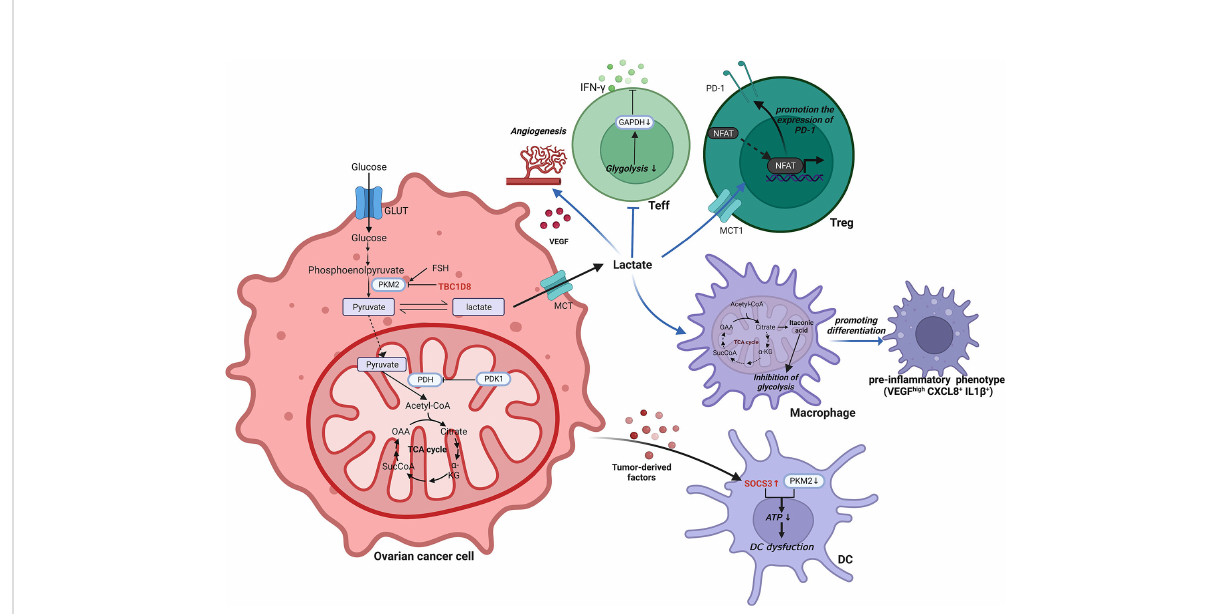
FIGURE 2 Reprogramming of glycolytic metabolism in the TIME of ovarian cancer. In the TIME of ovarian cancer, the reprogramming of glycolytic metabolism occurs in cells such as ovarian cancer cells, T cells, macrophages and DCs, resulting in a suppressive immune microenvironment that facilitates tumorigenesis and progression. ATP, Adenosine triphosphate; CXCL, C-X-C motif chemokine ligand; DC, Dendritic cell; FSH, Follicle-stimulating hormone; GAPDH, Glyceraldehyde-3-phosphate dehydrogenase; GLUT, Glucose transporter; IL, Interleukin; INF- g , interferon- g ; MCT, Monocarboxylate cotransporter; NFAT, Nuclear factor of activated T cells; OAA, Oxalacetate; PDH, pyruvate dehydrogenase; PDK1, Pyruvate dehydrogenase kinase 1; PD-1, Programmed death receptor 1; PKM2, Pyruvate kinase M2; SOCS3, Cytokine signaling 3; TBC1D8, TBC1 domain family member 8; TCA, Tricarboxylic acid; Teff, effector T cell; Treg, Regulatory T cell; VEGF, Vascular endothelial growth